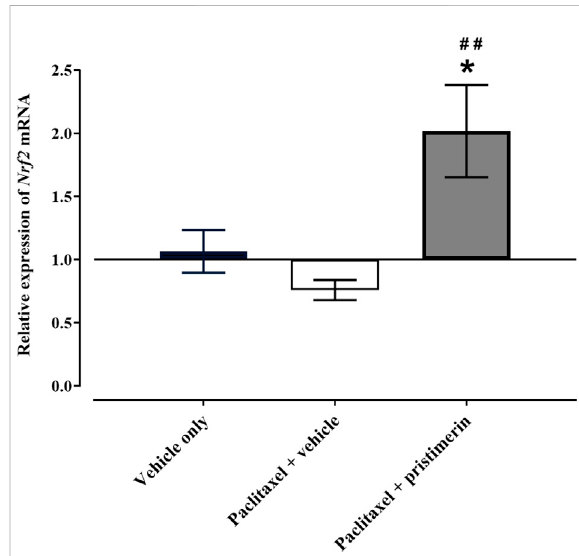
FIGURE 7 Effect of treatment with paclitaxel or paclitaxel + pristimerin on the relative expression of Nrf2 mRNA in paw skins of female BALB/c miceatday7post fi rst paclitaxel dose.Eachbarrepresents the mean ± SEM of values obtained from 5-6 animals. * p < 0.05 compared to control mice (treated with vehicle only) at day 7 and ## p < 0.01 compared to mice treated with paclitaxel + vehicle (one-way ANOVA was followed by Tukey ’ s multiple comparisons